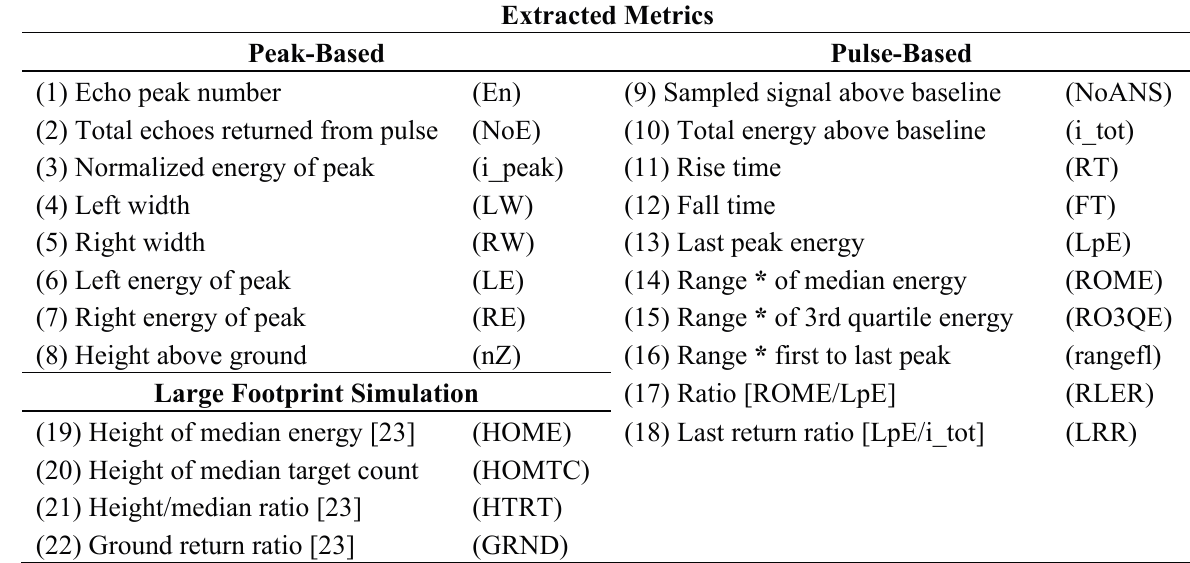
Table 2. LiDAR metrics tested for correlation.